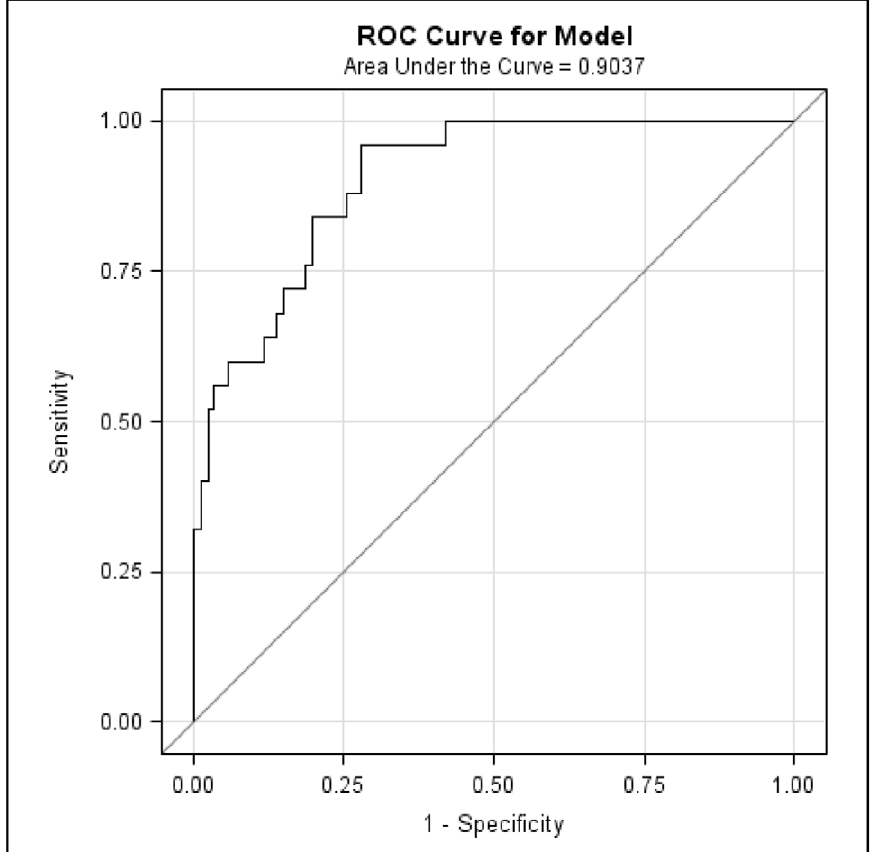
Figure 1. Receiver operating characteristic (ROC) curve for the eleventh test dataset (n=111). This figure shows the performance of the logistic regression model with the four predictive markers (7B8, 15D6, 16E4, 33F8) for the eleventh test dataset. The proportion of the predicted clinical strains out of the truly clinical strains (true positive rate or sensitivity) is plotted against the proportion of the predicted clinical strains out of the truly environmental strains (false positive rate or 1-specificity).